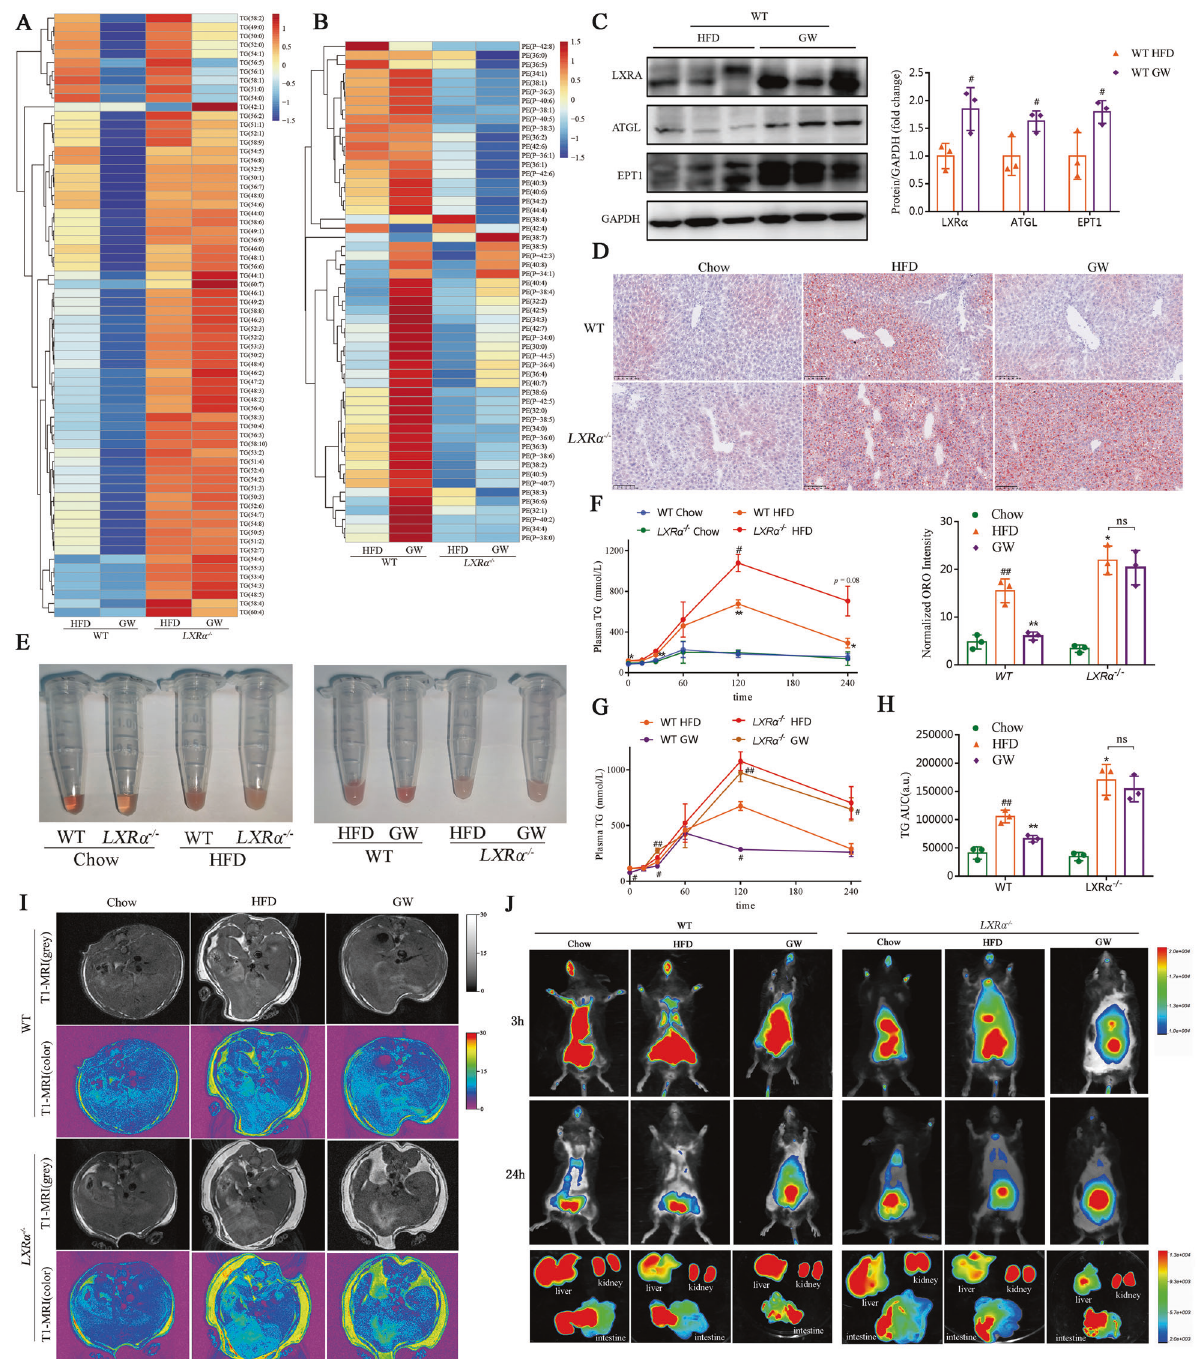
Fig. 5 LXR α plays an important role in maintaining lipid homeostasis by affecting TG metabolism and PE synthesis. A Heatmap of species of TG containing different lengths of fatty acids based on the concentrations (nmol/g) in the liver of mice treated with LXR agonizts GW3965 or not. The increased TG species code the color as red in the heatmap; the decreased ones code the blue ( n = 5). B Heatmap of species of PE containing different lengths of fatty acids based on the concentrations (nmol/g) in the liver of mice treated with vehicle or GW3965. The increased PE species code the color as red in the heatmap; the decreased ones code the blue ( n = 5). C Western blot analysis of LXR α , ATGL and EPT1 proteins in mice from group WT HFD, WT GW. D – H Image of Oil red O staining of liver of mice (Insert showing the ORO intensity) ( D ), plasma samples ( E ) and plasma TG levels (inset showing the AUC values for plasma TG) ( F – H ) after oral gavage of olive oil (10 μ l/g) ( n = 3). Data are mean ± SD. * P < 0.05 and ** P < 0.01 were compared with WT Chow; # P < 0.05 and ## P < 0.01 were compared with WT HFD. The samples shown in plasma photos and ORO staining were collected at 2 h after oral gavage of olive oil. Scale bar, 100 μ m. I Representative T1-MRI images showing lipid accumulating contents in livers of mice treated with vehicle or GW3965. J Representative in vivo imaging system images of mice after tail vein injection of cy7-labeled phosphoethanolamine. And representative images of cy7-labeled phosphoethanolamine fl uorescence intensity in mice live. Mice livers, kidneys, and intestines were collected at 24 h after tail vein injection of cy7-labeled